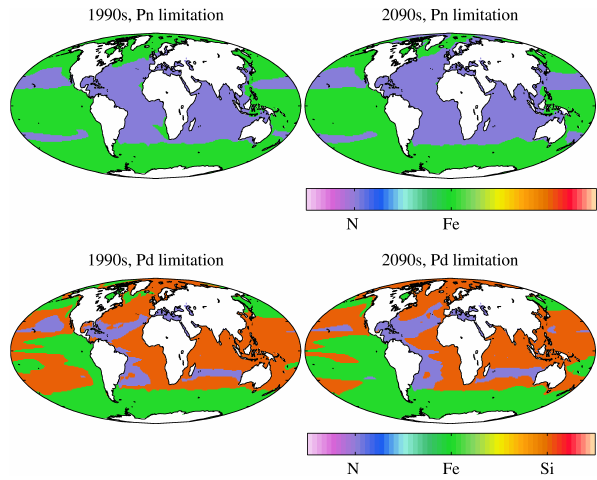
Fig. 15. Annual average 1990s (left) and 2090s (right) limiting nu- Fig. 13. Annual average 1990s ( left ) and 2090s ( right ) limiting nutrient for non–diatom phytoplankton ( top ; –) and limitingnutrientfordiatomphytoplankton( bottom ;–). trient for non-diatom phytoplankton (top; –) and limiting nutrient for diatom phytoplankton (bottom; –).